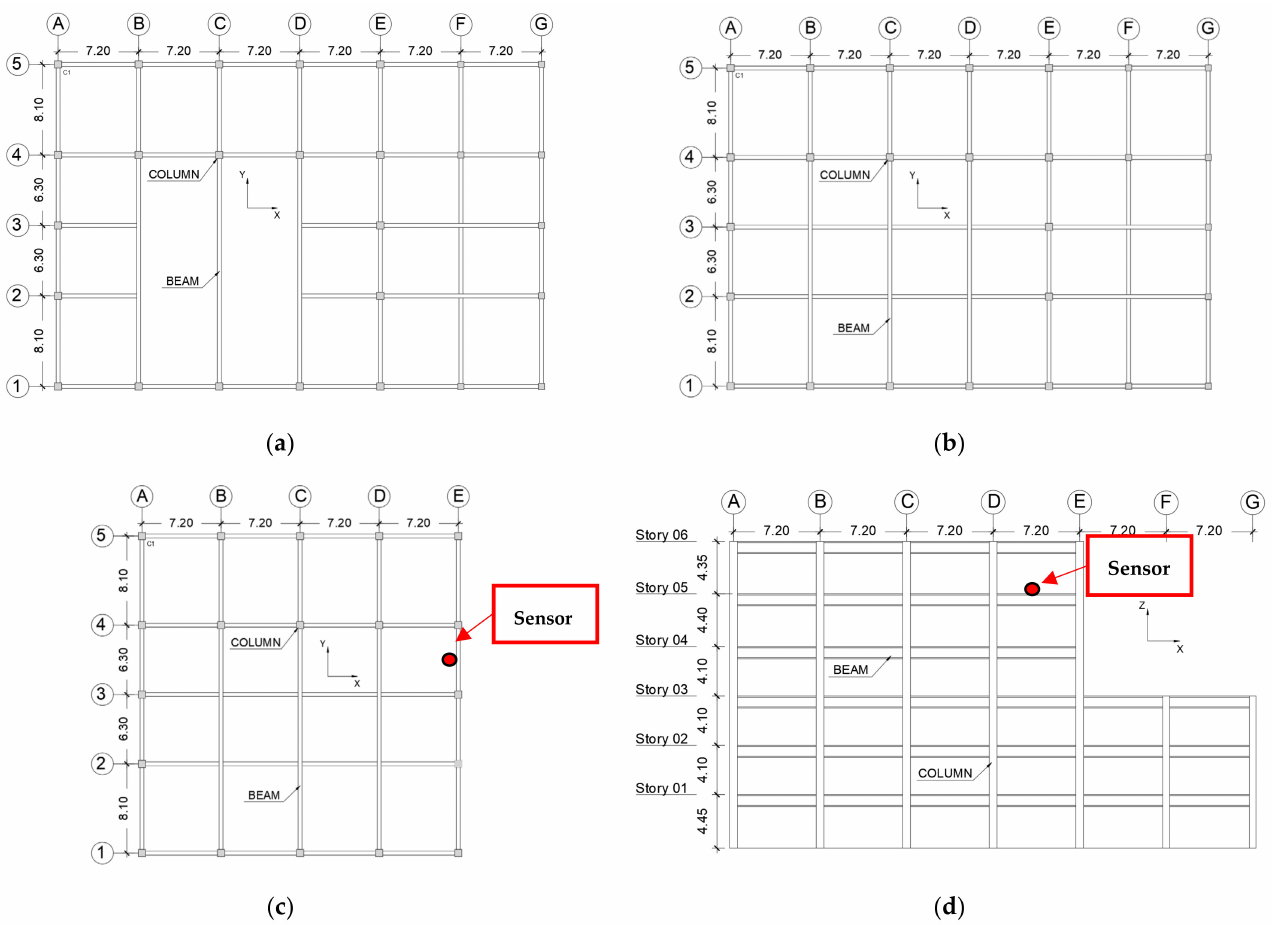
Figure 3. General drawings of Tahara City Hall building. ( a ) Plan of 1st storey view. ( b ) Plan of 2nd and 3rd stories’ views. ( c ) Plan from 4th to 6th storey view. ( d ) Elevation of X-direction